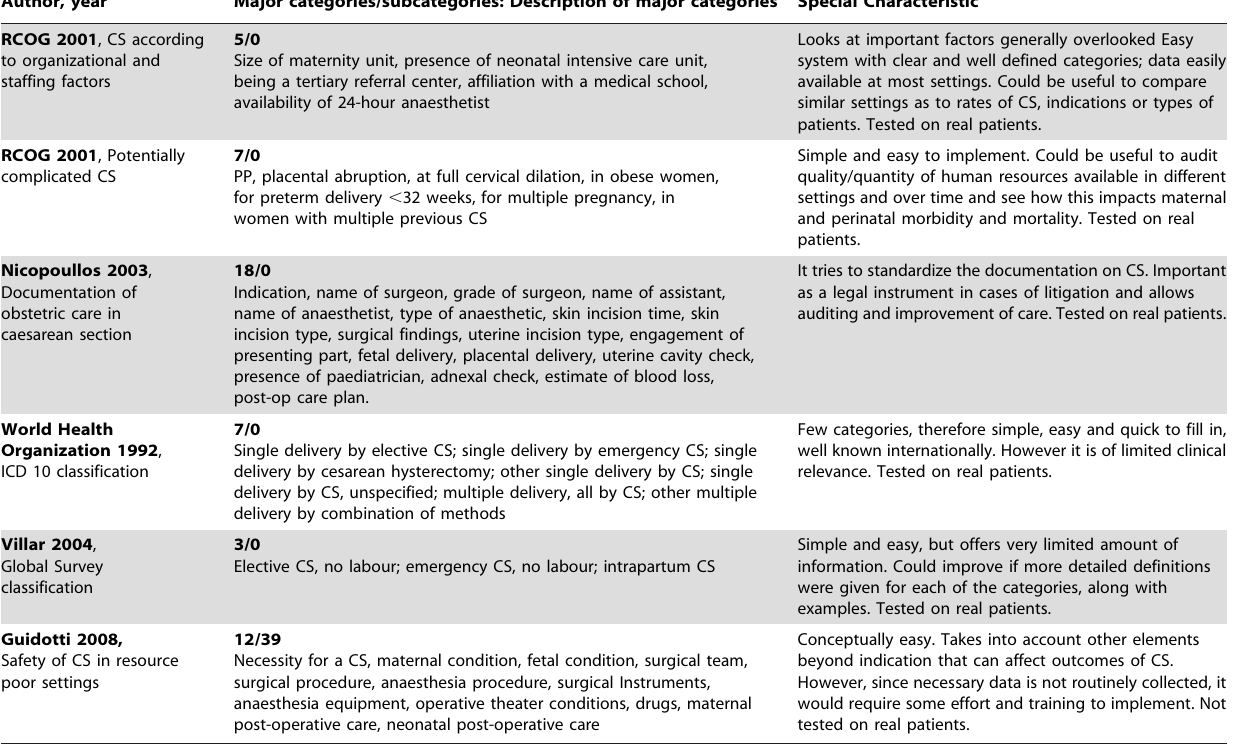
Table 7. Other types of classifications for caesarean